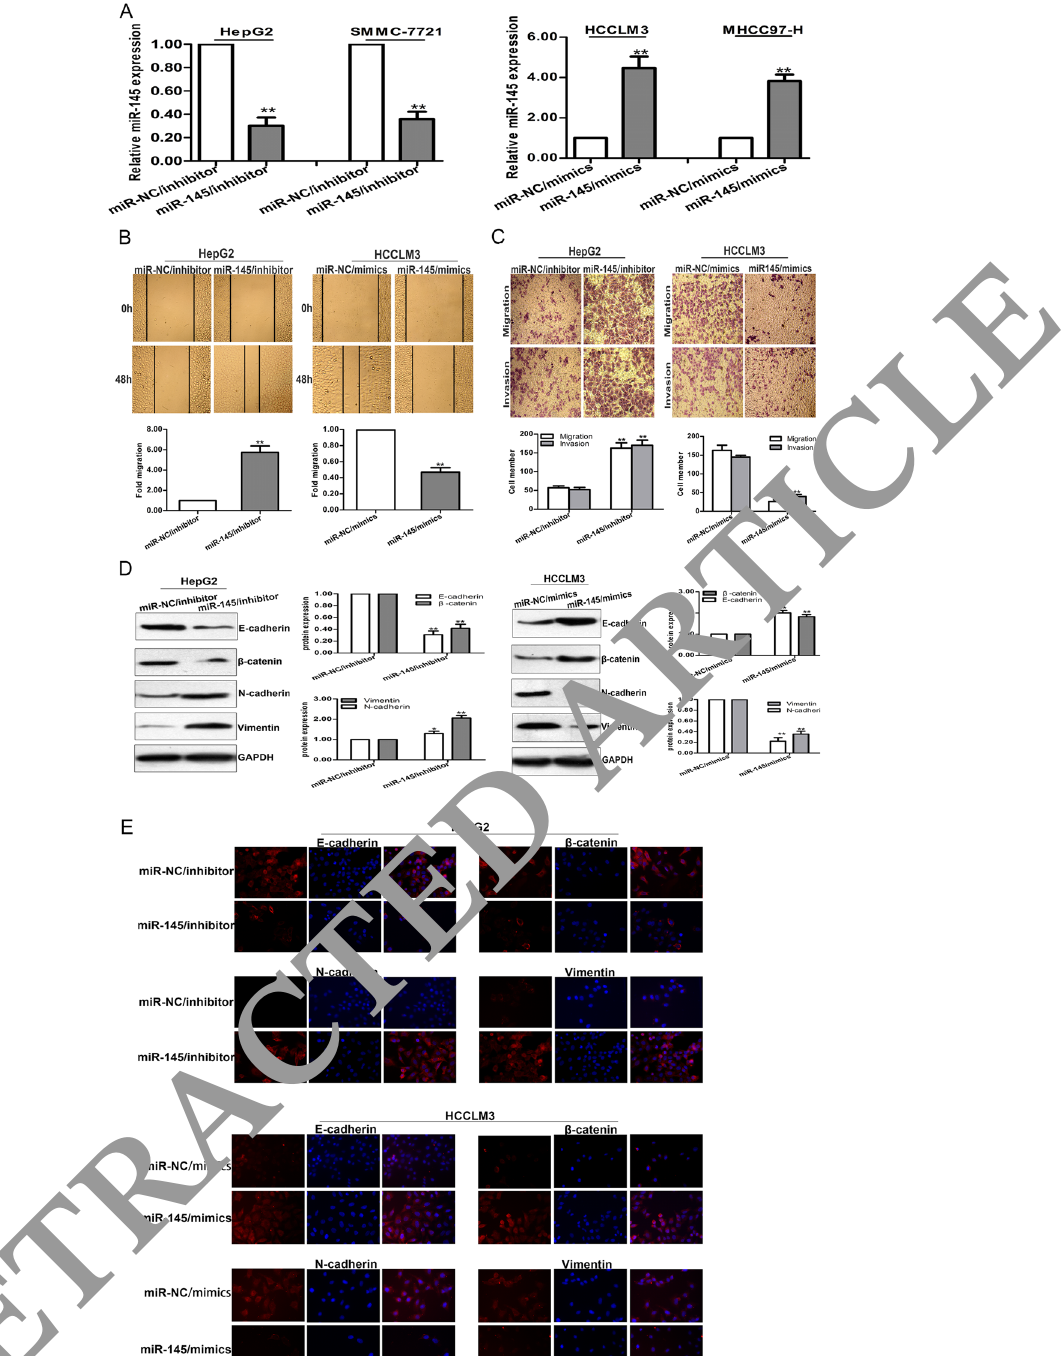
Figure 5. miR-145 negatively regulates invasion, migration and EMT phenotype of HCC cells. ( A ) qRT-PCR detection of miR-145 expression in miR-145/inhibitor transfected HepG2 or SMMC-7721 cells and miR-145/ mimics transfected HCCLM3 or MHCC97-H cells. ( B ) Wound healing assay, and ( C ) transwell assays on HepG2 cells transfected with miR-145/inhibitor (or miR-NC/inhibitor) and HCCLM3 cells transfected with miR-145/mimics (or miR-NC/mimics), respectively. ( D ) Western blotting and ( E ) immunofluorescence analysis of changes in epithelial and mesenchymal markers of miR-145/inhibitor transfected HepG2 cells and miR-145/ mimics transfected HCCLM3 cells. Each experiment was performed at least three times. * p < 0.05; ** p <